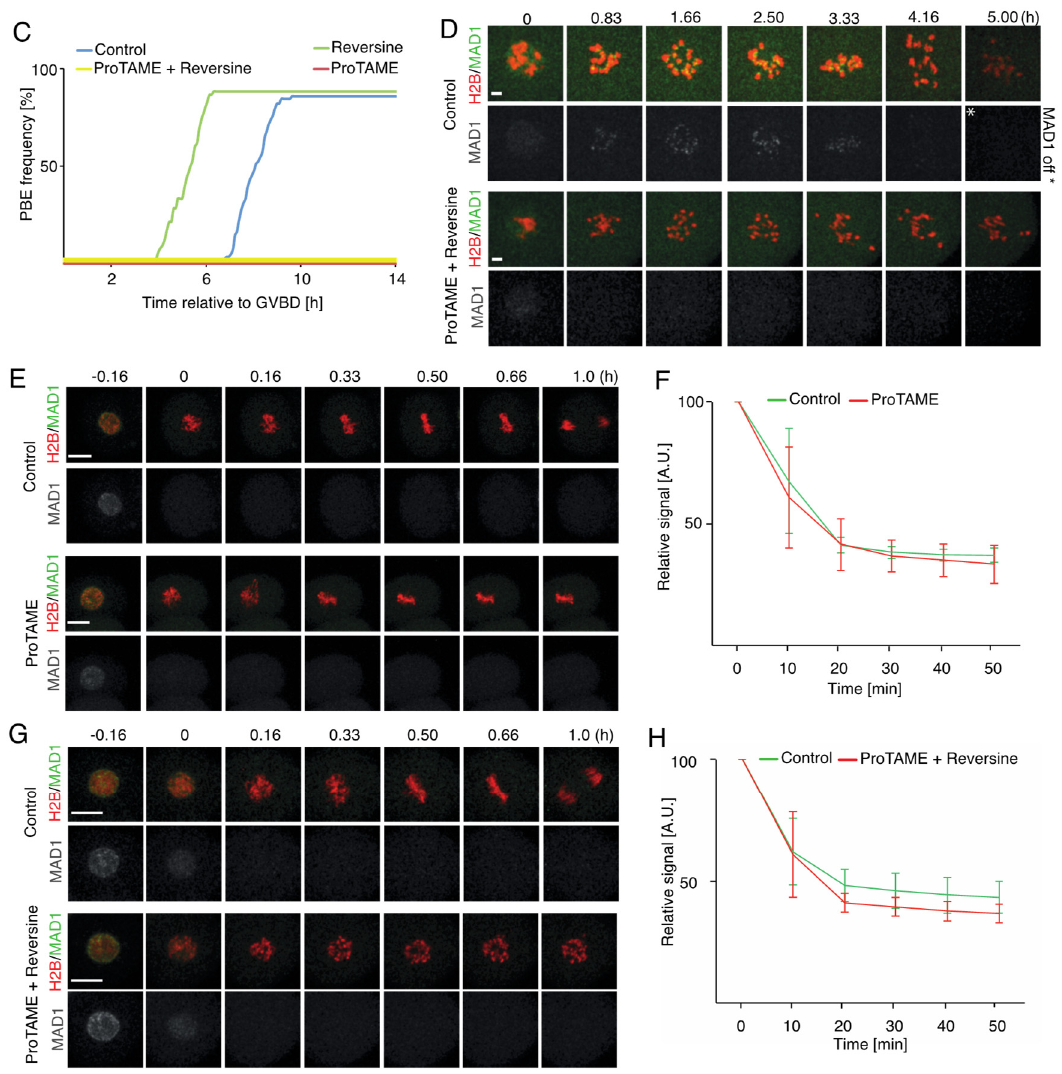
Figure 7. ProTAME-induced arrest in mouse oocytes and two-cell embryos does not require SAC activity. ( A ) Time frames from live cell imaging experiment showing MAD1 localization: upper panel—control cell; lower panel—cell exposed to 5 µ M proTAME. MAD1 (green) and HISTONE H2B (red) visualized by fusion into fluorescent proteins. The time frame with MAD1 removal (MAD1 o ff ) from chromosomes is indicated with an asterisk. 0 h = GVBD. Scale bar: 5 µ m. ( B ) Scatter plot showing GVBD–MAD1 o ff interval in control oocytes ( n = 17) and 5 µ M proTAME-treated oocytes ( n = 33). Data were obtained in three independent experiments. The red line represents the mean. The di ff erence between control and proTAME-treated cells is statistically significant ( α < 0.05; ** p < 0.010). ( C ) Cumulative graph showing the timing of polar body extrusing (PBE) during meiosis I in control oocytes (blue, n = 84), in oocytes treated with 500nM reversine (green, n = 60), in oocytes treated with 5 µ M proTAME (red, n = 20) and in oocytes treated with 5 µ M proTAME + 500 nM reversine (yellow, n = 58). Data were collected in two independent experiments. ( D ) Time frames from live cell imaging experiment using GV oocytes showing MAD1 localization, where upper panels represent the control cell, and lower panels represent the cell exposed to 5 µ M proTAME + 500 nM reversine. MAD1 (green) and histone H2B (red) visualized by fusion to fluorescent proteins. The time frame with MAD1 removal (MAD1 o ff ) from chromosomes is indicated with an asterisk (control). 0 h = GVBD. Scale bar: 5 µ m. ( E ) Time frames from live cell imaging experiment with two-cell embryos showing MAD1 localization; upper panels represent the control cell, lower panels represent the cell exposed to 20 µ M proTAME. MAD1 (green) and